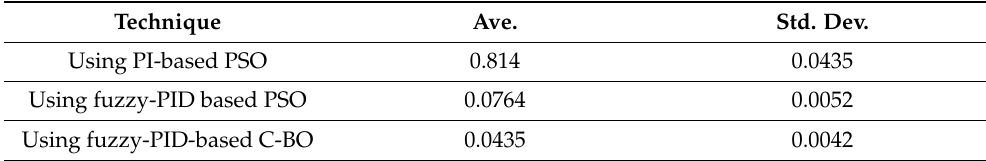
Table 8. Comparison of statistical results.